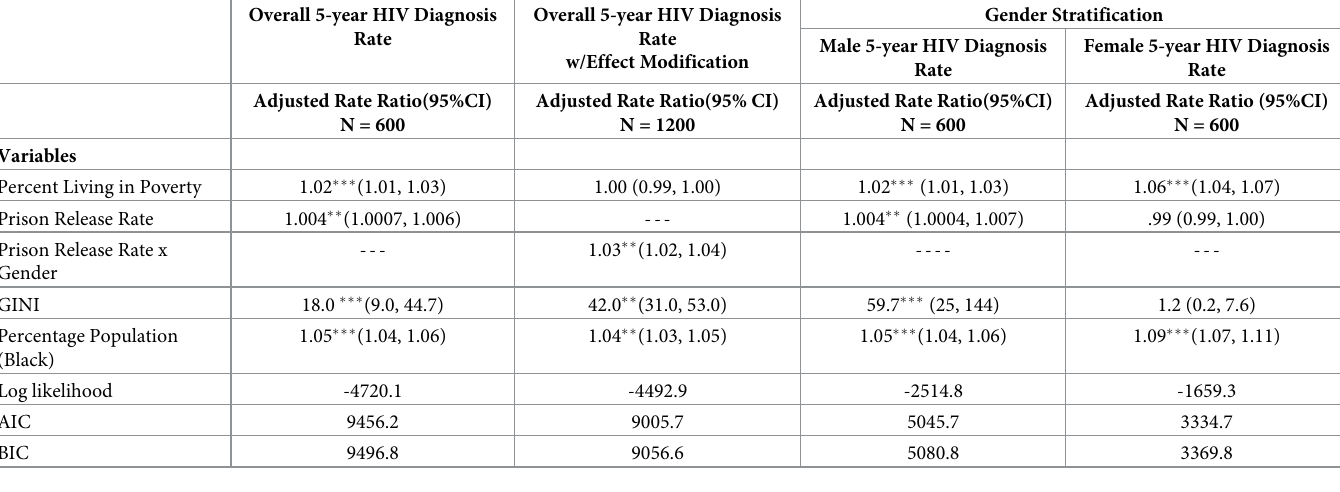
Table 4. Multilevel regression models of overall and gender stratified 5-year HIV diagnoses